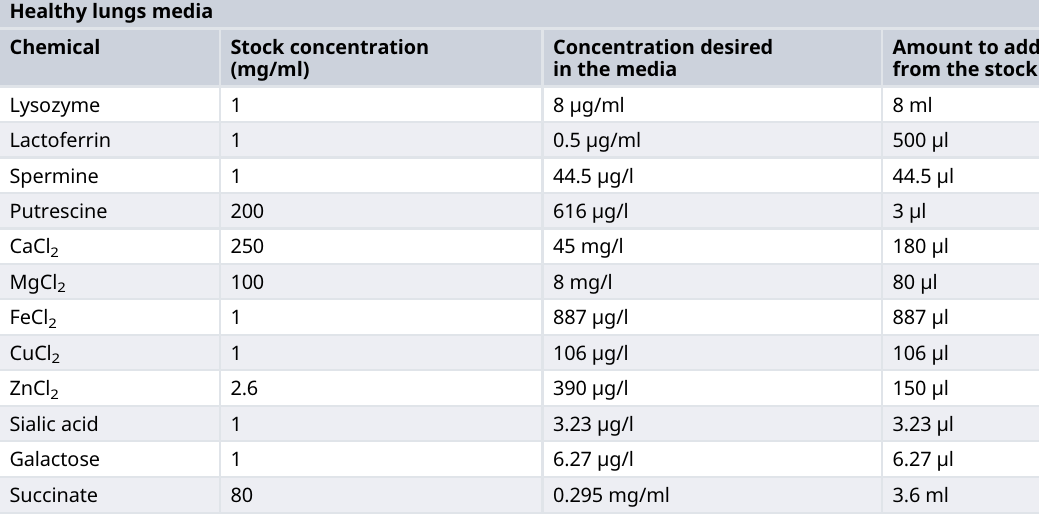
Table 12. Volumes of each chemical to add into the base media for 1liter HLM. Healthy lungs